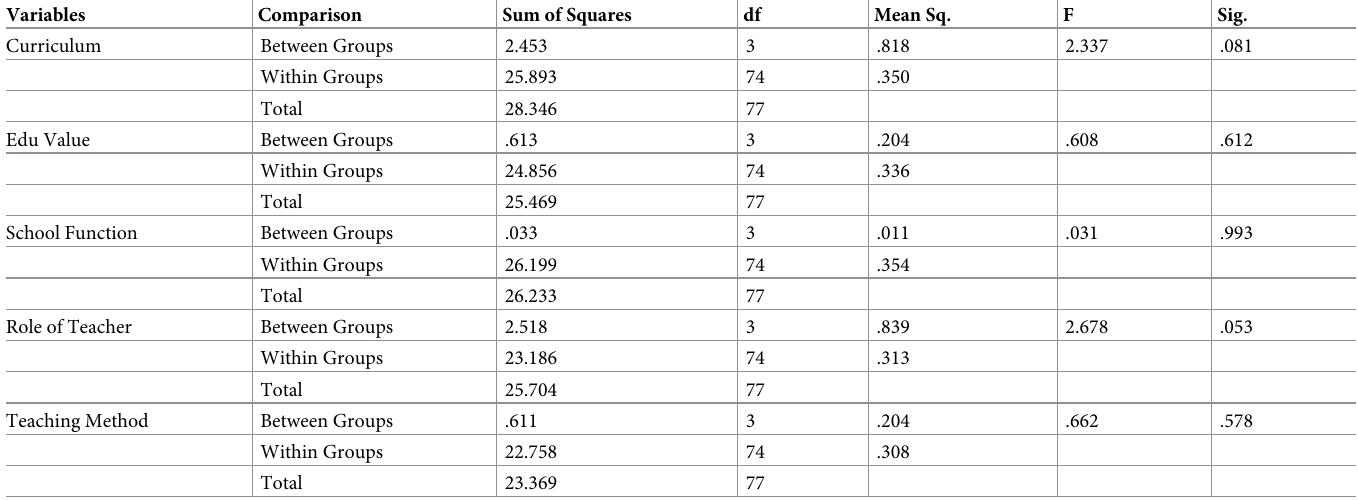
Table 11. Comparison of teachers with their teaching experience with respect to the five categories.